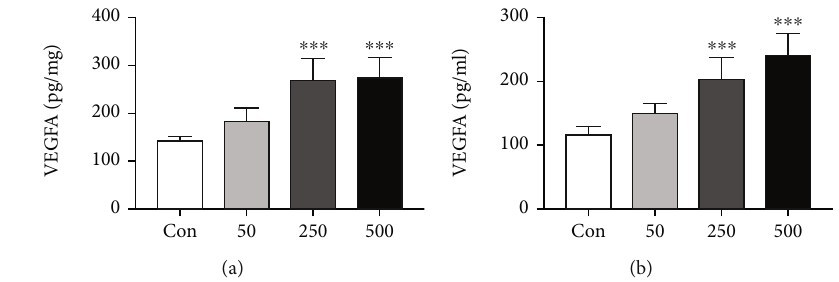
Figure 2: VEGFA expression in the HCT-116 (a) cells and (b) cell supernatants after incubation with di ff erent concentrations of TMAO. ∗∗∗ P < 0 : 001 versus Con group ( n = 5